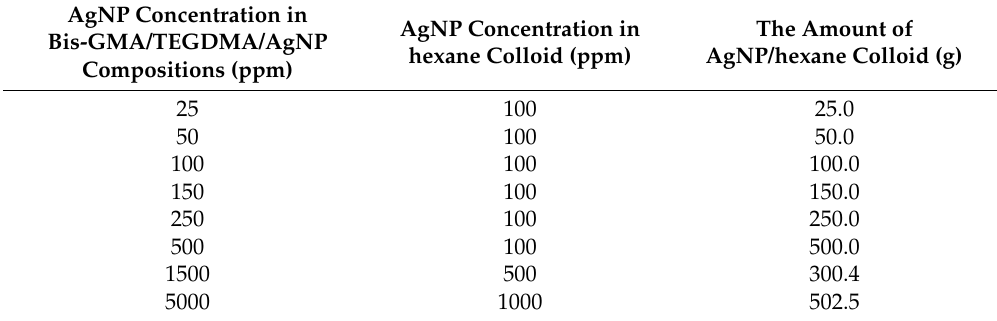
Table 1. The AgNP concentrations in Bis-GMA/TEGDMA/AgNP compositions, AgNP concentrations